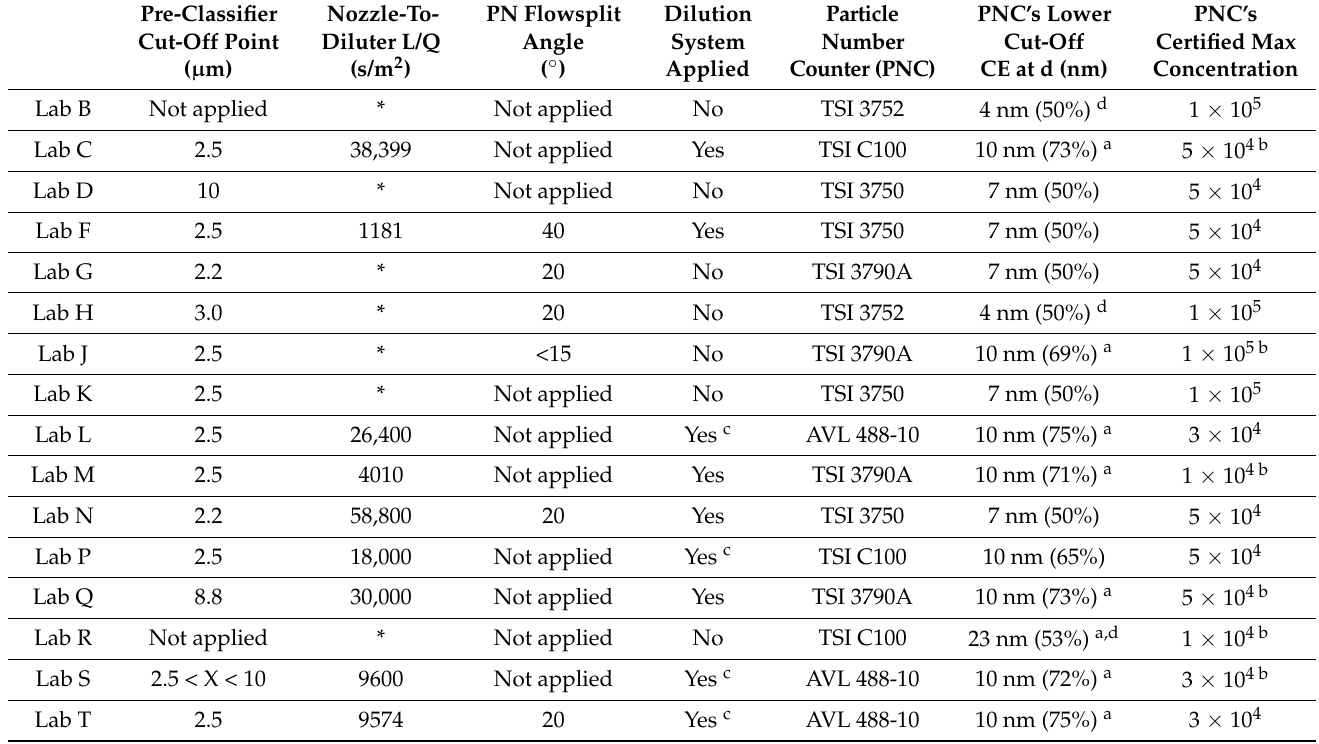
Table 2. Main elements of the PN-related instrumentation used at the ILS by the testing